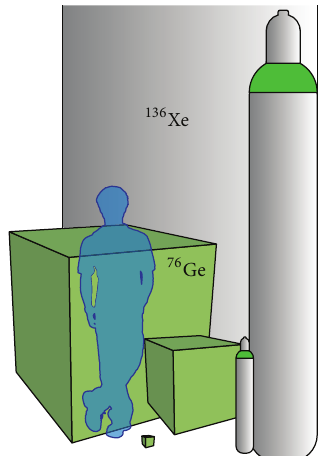
Figure 18: Masses corresponding to present, mega, and ultimate exposures, assuming zero background condition and 5 years of data acquisition. The cubes represent the amount of 76 Ge, the (150 bar = 15MPa) bottles, and the one of 136 Xe. The smallest masses depict the present exposure, while the biggest bottle is out of